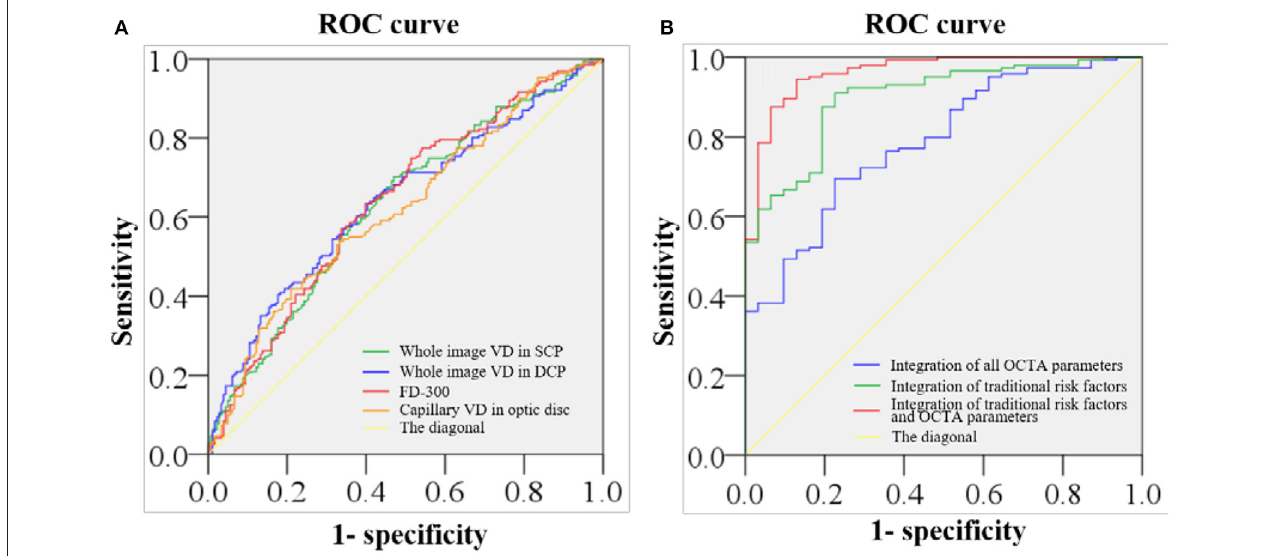
FIGURE 2 | ROC of retinal VD in distinguishing stroke from non-stroke. (A) The area under the receiver operating characteristic curve (AUC) of the macular VD of SCP, the macular VD of DCP, the VD within a 300- µ m wide ring surrounding the foveal avascular zone (FAZ) (FD-300), and the optic disc VD of capillary is 0.630, 0.639, 0.638, and 0.619, respectively. (B) The AUC of the integration of all optical coherence tomography angiography (OCTA) parameters is 0.787, with the sensitivity of 0.694 and the specificity of 0.774. The AUC of the integration of traditional risk factors is 0.894, with the sensitivity of 0.89 and the specificity of 0.774. The AUC of the integration of all OCTA parameters and traditional risk factors 0.962, with the sensitivity of 0.944 and the specificity of